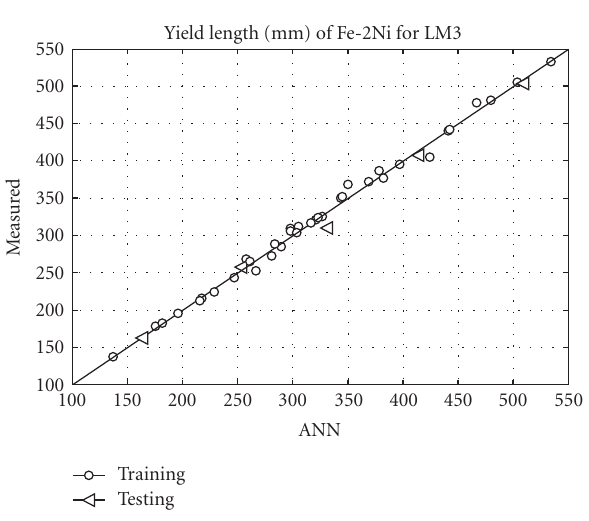
Figure 21: Comparison of the measured and predicted yield length for Fe − 2Ni.